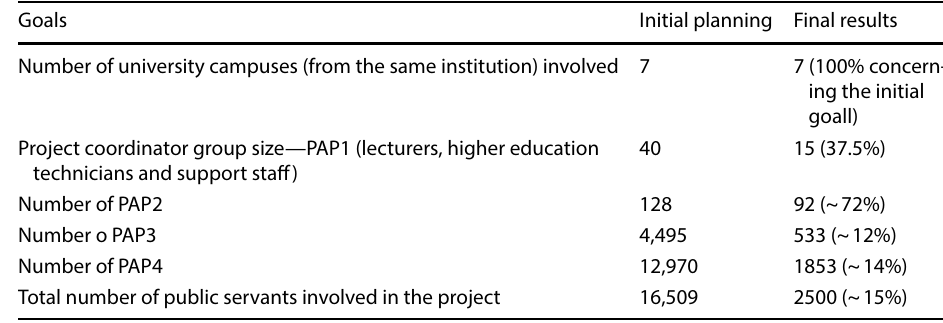
Table 3 Comparison between the initial goals of training HEI employees and the result achieved at the end of the